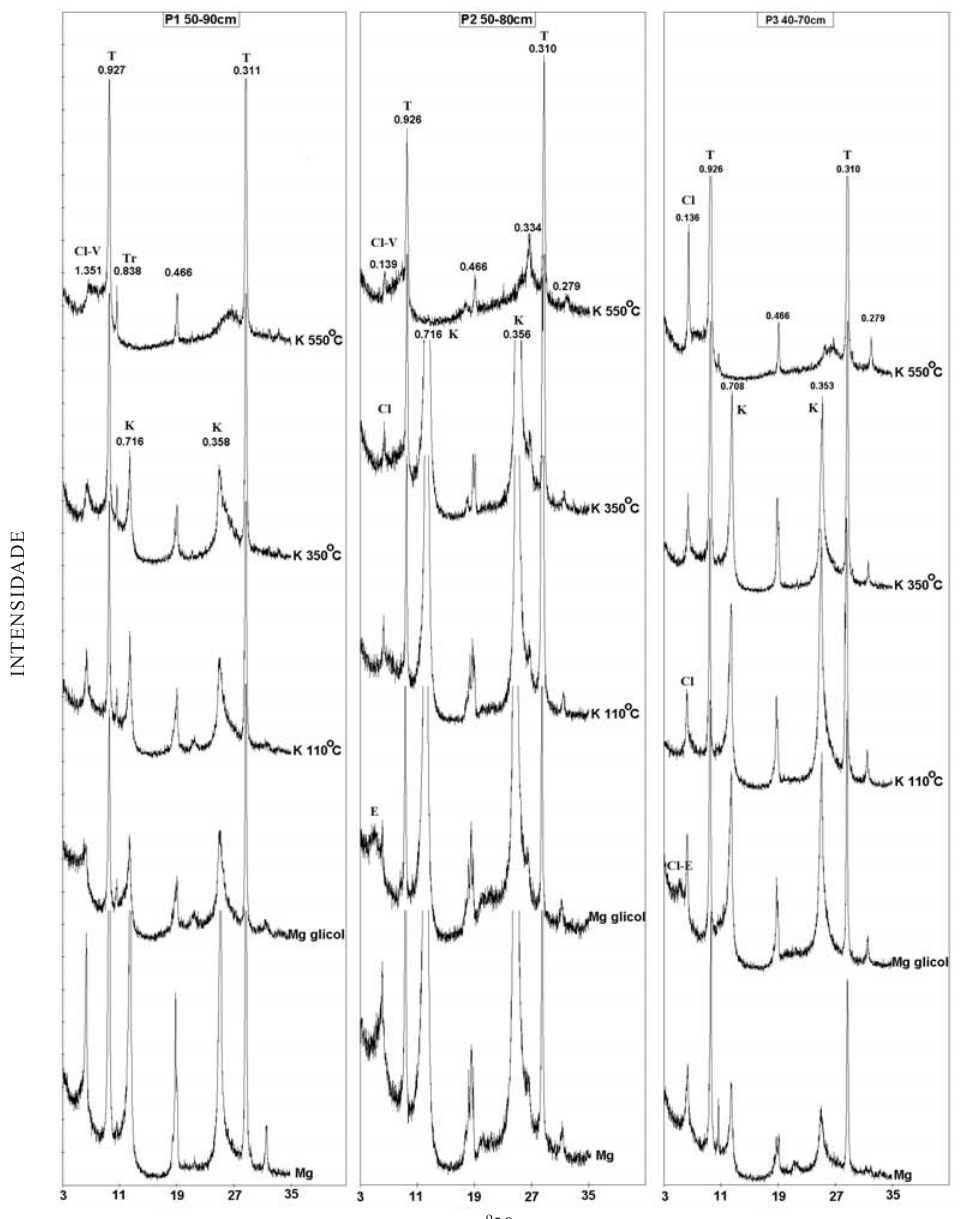
Figura 7. Difratogramas de raios X da fração argila dos horizontes Bi dos três perfis estudados. T:talco; Tr: tremolita; K:caulinita; Cl: clorita; E: esmectita; Cl-E:interestratificado clorita-esmectita; Cl-V: interestratificado